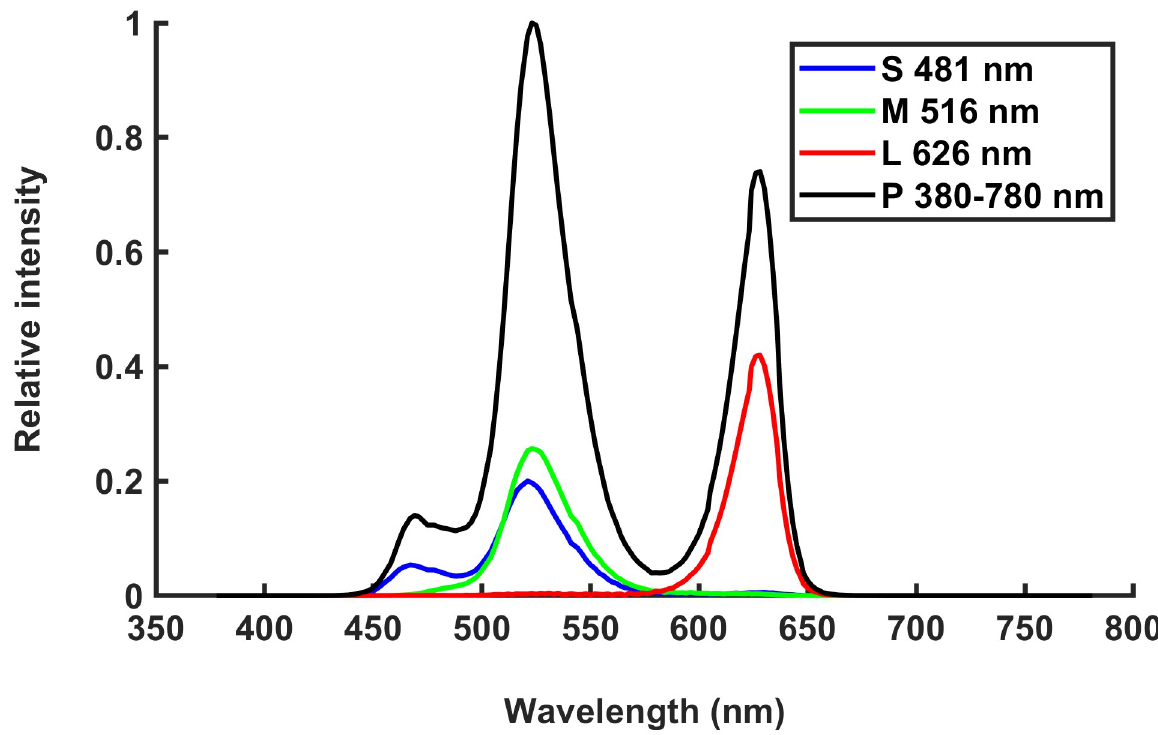
Fig 5. Normalized intensity (normalized spectra including luminosity function V( λ )) of stimulation conditions with short- (S), middle- (M), long-wavelengths (L) and polychromatic (P) light emitted from ViewPixx/3D.